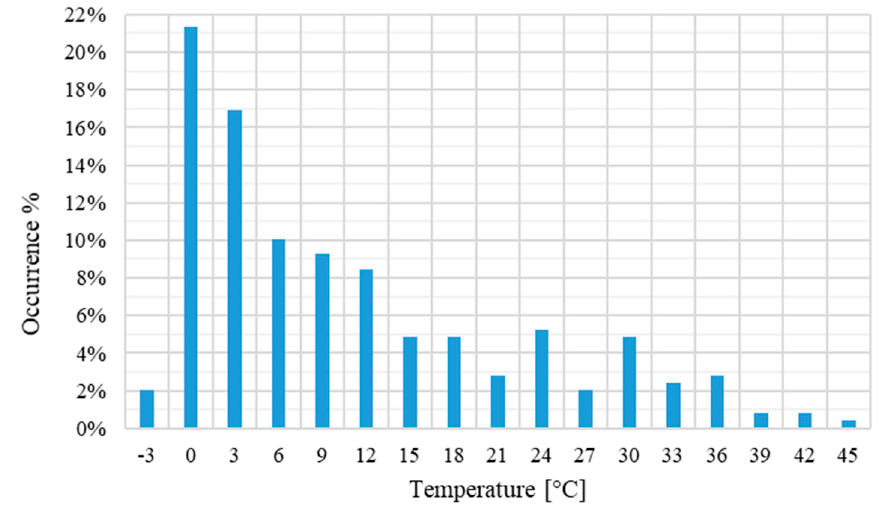
Figure 8. Percentage of time a certain temperature occurs in the greenhouse.